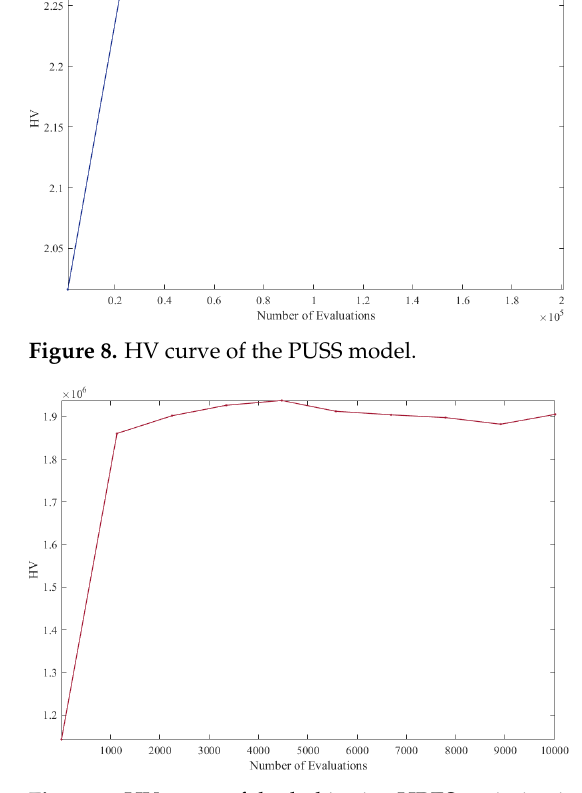
Figure 9. HV curve of dual-objective HRES optimization. Table 2. Time cost data of